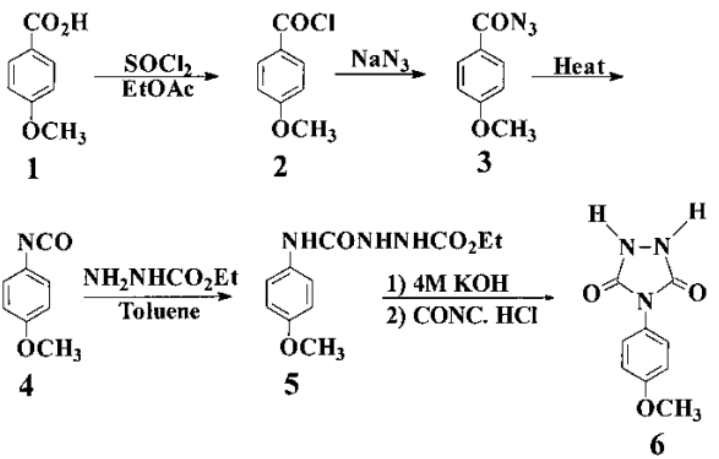
Figure 50. Synthesis of ureazole monomers. From reference [76].